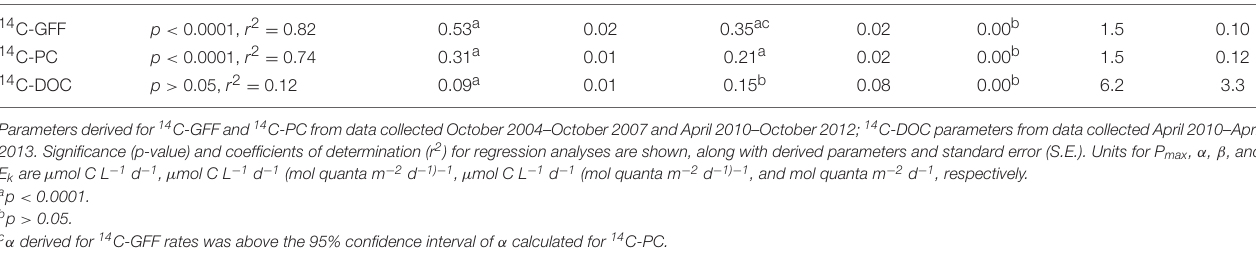
TABLE 3 | Descriptive characteristics of production-irradiance curve fitting results based on the Platt et al. (1980) model. Rate Curve fitting significance P max P max S.E. α α S.E. β E k E k S.E.